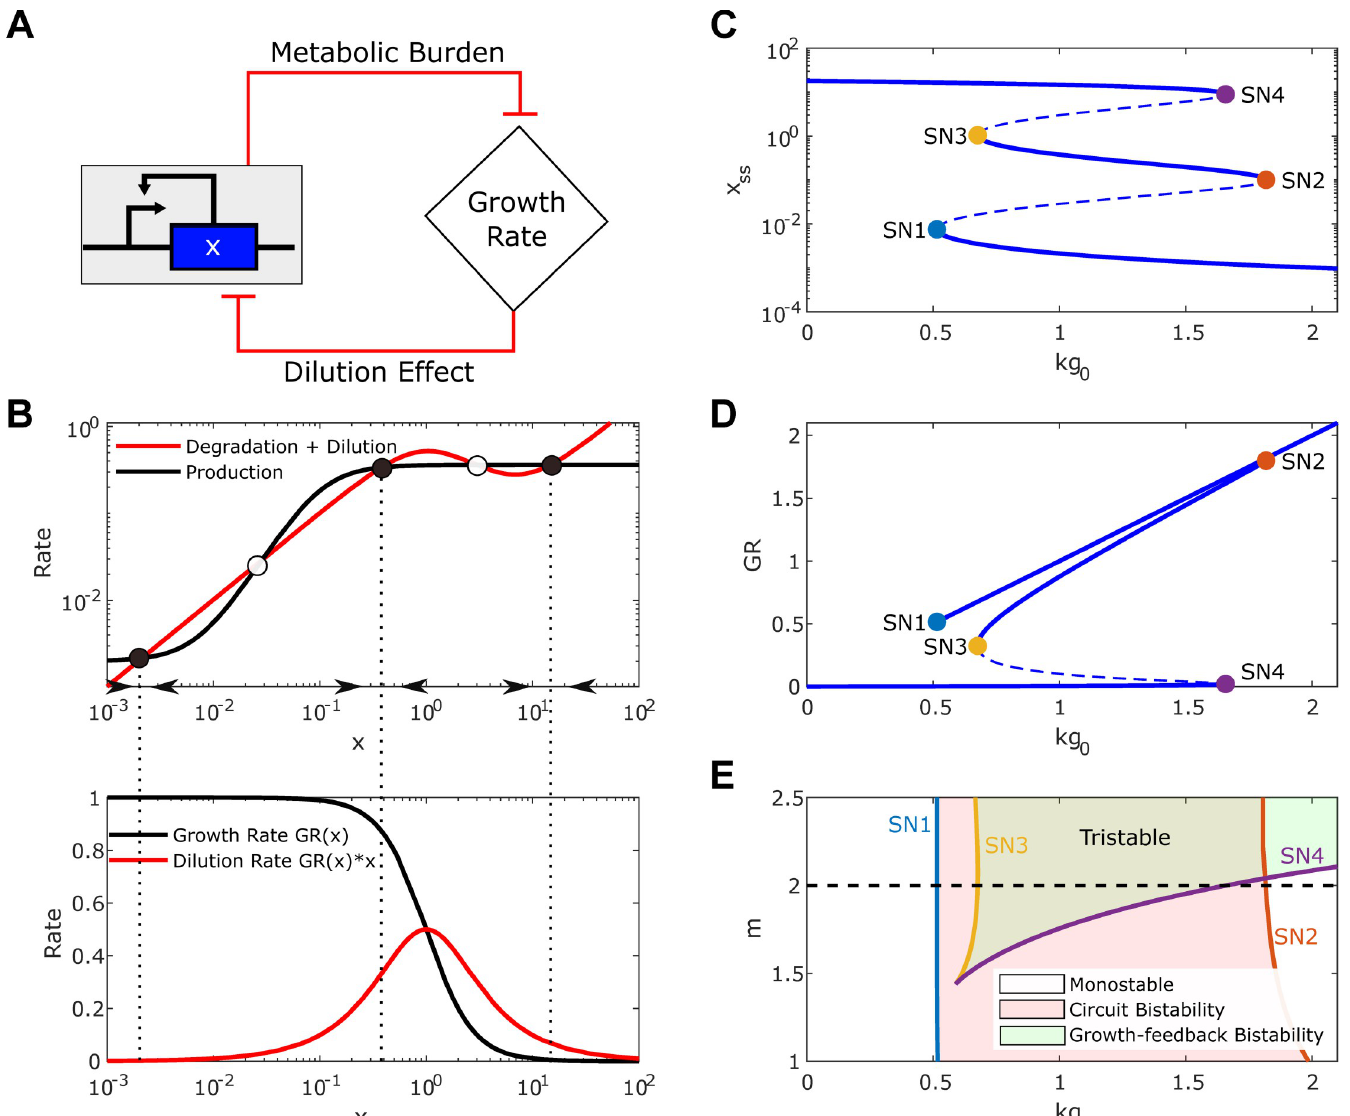
Fig 2. Tristability Emergence in the self-activation switch under ultrasensitive growth feedback. (A) Mutual inhibition interaction between growth rate and self- activation circuit. (B) The rate balance plot shows the emergence of tristability (top) based on the production rate curve ( f ( x ), black line) and degradation plus dilution rate d ( x ) (red line, top) versus gene expression x . Solid and open circles represent stable and unstable steady states. The black arrows denote the directional field. The corresponding growth rate (black line) and dilution rate (red line) curves are shown in the bottom panel. Vertical dotted lines between the top and bottom panels represent the x values at stable steady state. (C) Bifurcation diagram of the gene expression x with respect to kg 0 . Solid and dashed lines correspond to the stable and unstable steady states. (D) Bifurcation diagram of growth rate with respect to kg 0 . The solid circles in C-D mark Saddle-Nodes SN1~4. (E) Two-parameters bifurcation diagram with respect to m and kg 0 shows the dependence of the Saddle-Nodes SN1 (blue line), SN2 (orange line), SN3 (yellow line), and SN4 (purple line) on m . The region encloses between SN1 and SN2 corresponds to the bistability from the self-activation circuit. The region between SN3 and SN4 represents the bistability from ultrasensitive growth feedback. The overlap region of the two bistable regions gives